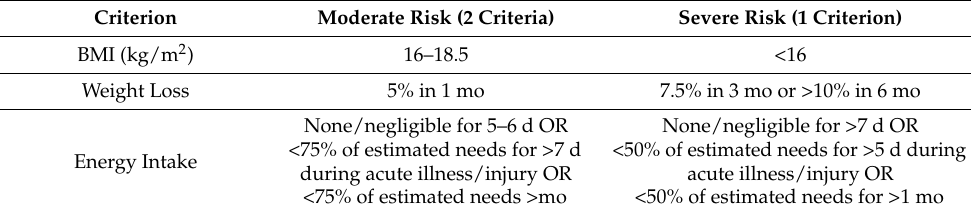
Table 1. ASPEN criteria to identify risk of refeeding in adults